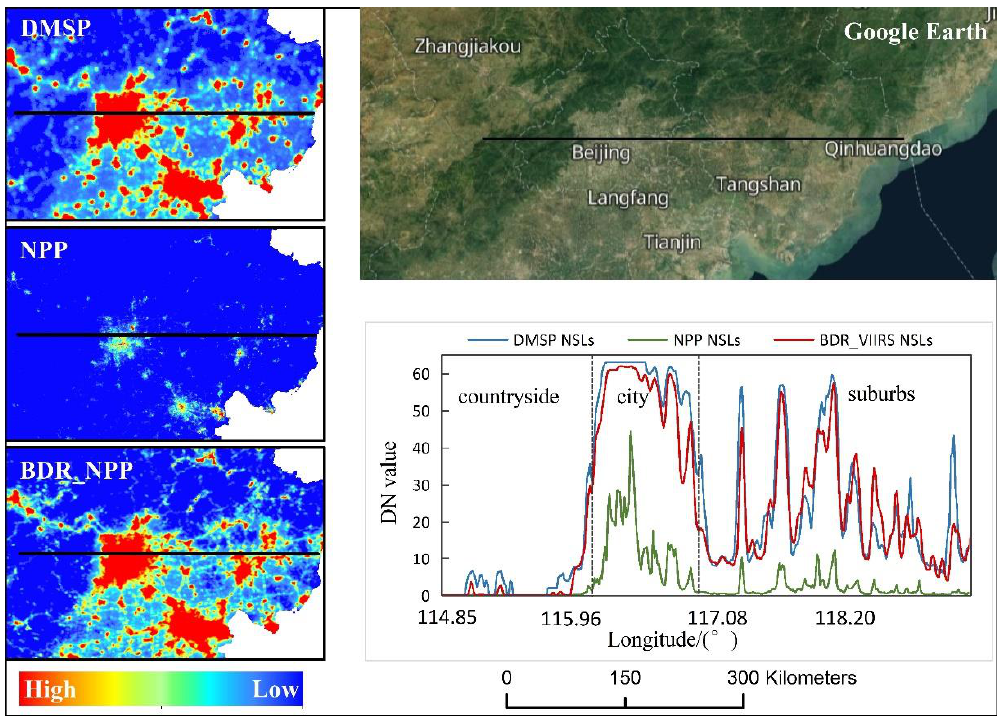
Figure 5. Profile distribution of radiation value of light images at different nights in 2013.